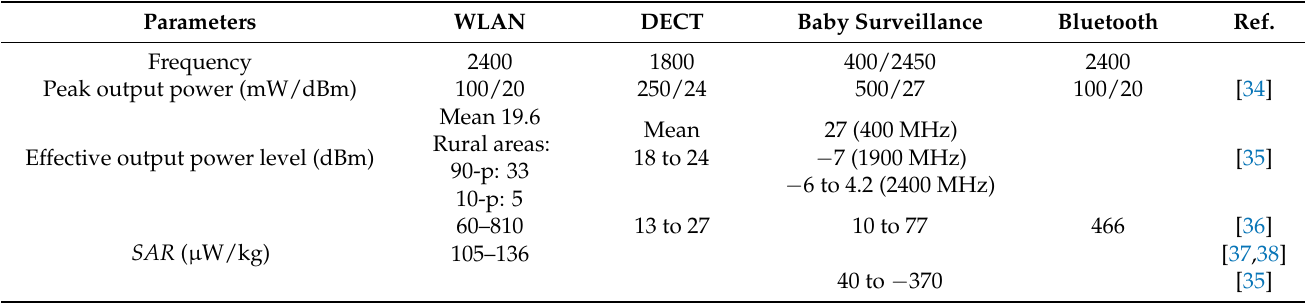
Table 4. Technical characteristics of RF-emitting indoor devices: peak output given in mW and dBm, the effective output level taking into account the duty factor, and the corresponding SAR values. Parameters WLAN DECT Baby Surveillance Bluetooth Ref.